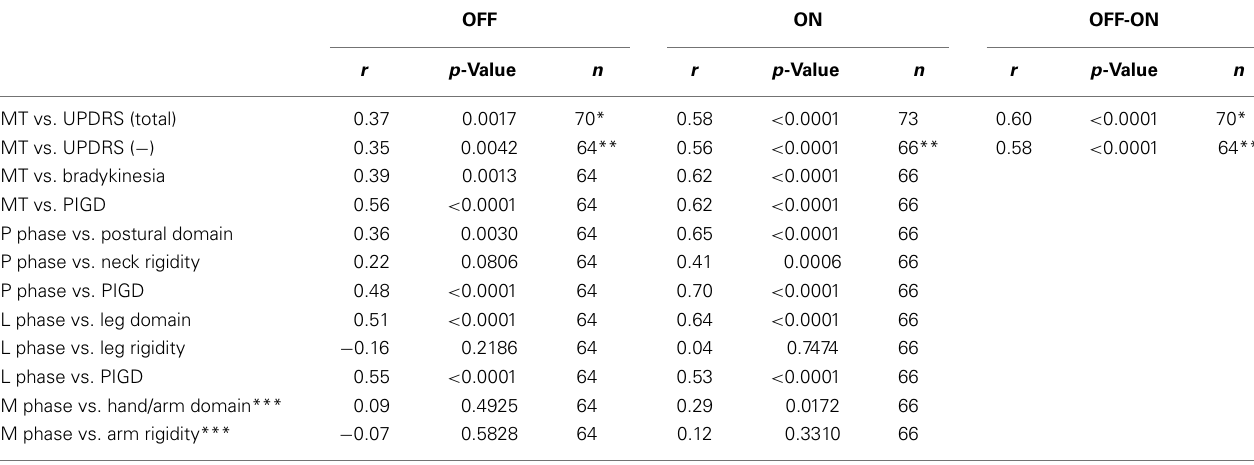
Table 3 | Correlation between PLM results and the UPDRS in all patients. OFF ON OFF-ON r p -Value